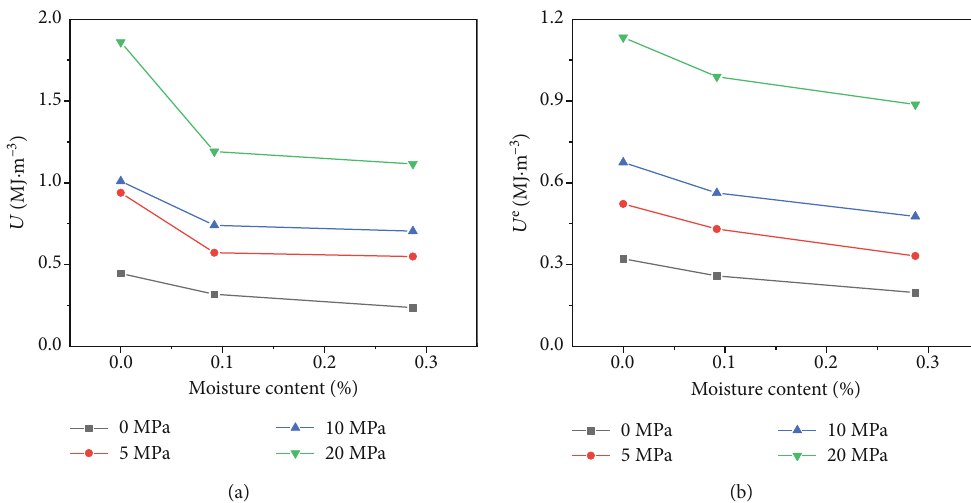
Figure 9: Relationship between the total input energy and elastic strain energy at peak point and water content: (a) total input energy; (b) elastic strain energy.